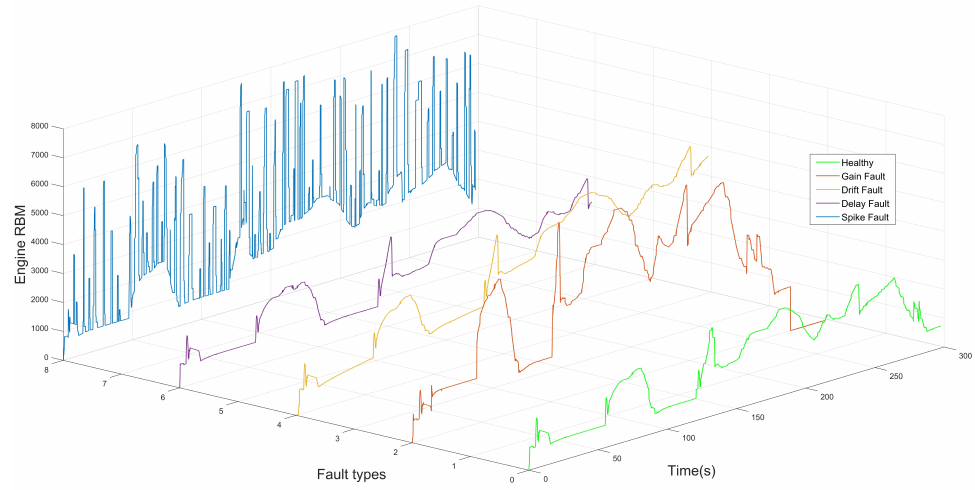
Figure 3. Healthy signal and fault types: Gain fault, Drift fault, Delay fault, Spike